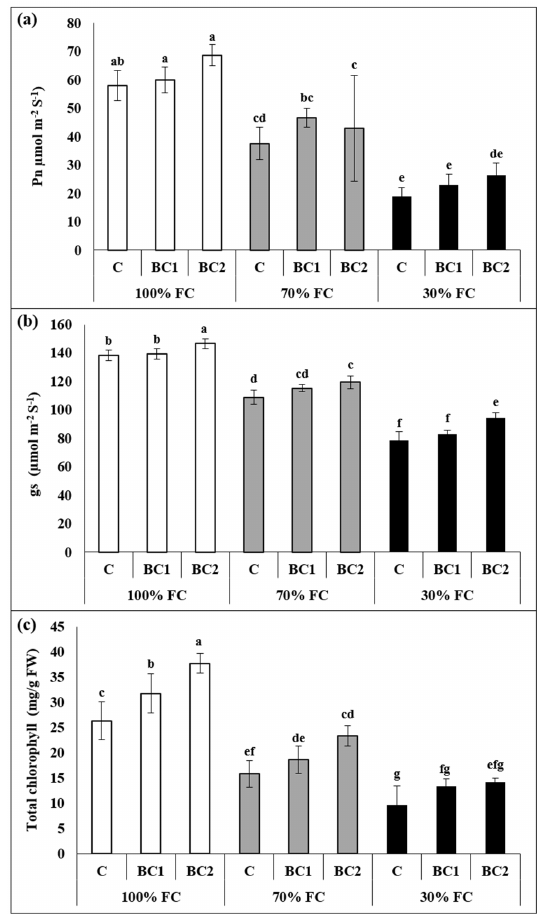
Figure 1. Improvement in the photosynthetic efficiency of L. fusca plants by biochar amendment under drought stress. ( a ): photosynthetic rate (Pn), ( b ): stomatal conductance (gs), ( c ): total chlo- rophyll. In addition, FC and BC represent fi eld capacity and biochar, respectively. The values marked with different letters are significantly different from each other at p ≤ 0.05 levels in each parameter (ANOVA) followed by least significant difference (LSD) test. 3.2. Alleviation of Oxidative-Stress Biomarkers by Biochar under Drought Stress Under water-limited conditions, L. fusca plants substantially produced reactive ox- ygen and methylglyoxal species including H 2 O 2 , OH - , O 2- , MDA, and MG. At 70% FC, H 2 O 2 , OH − , O 2 − , MDA, and MG increased by 1.9-, 2-, 1.7-, 2.3-, 3-fold, while a ft er 30% FC, this elevation was 5.1-, 3-, 2.3-, 3.3-, 4.4-fold, respectively (Figure 2). However, BC-1 ap- plication signi fi cantly reduced the reactive species of L. fusca by 31%, 25%, 12%, 24%, and